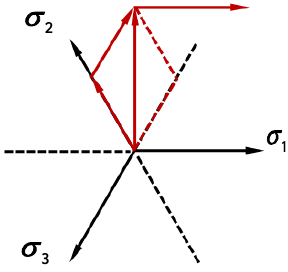
Figure 5. Stress path of strength envelope curve.